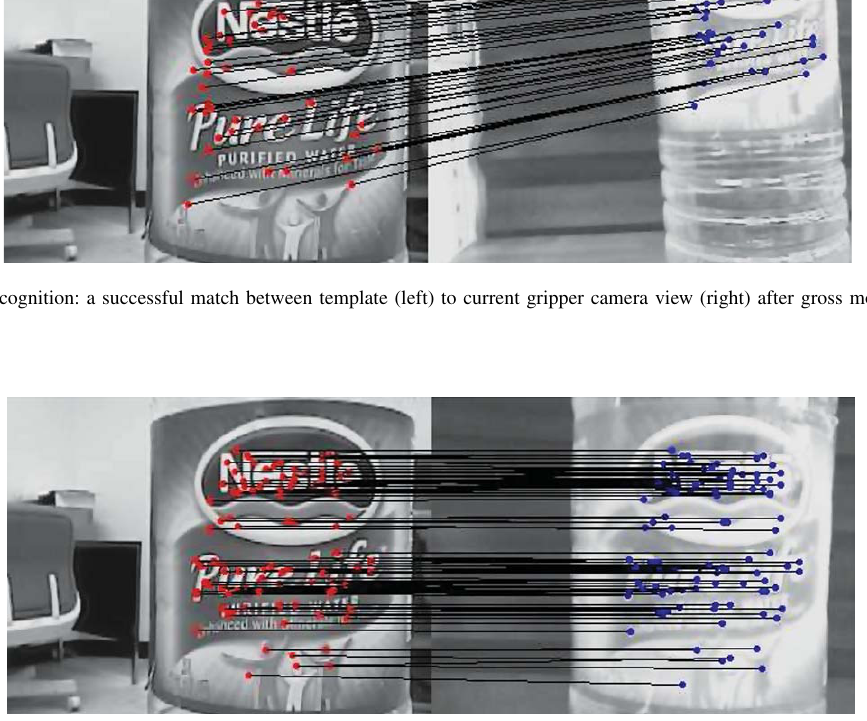
Fig. 8. Successful fine motion alignment between template (left) and left gripper camera view (right) (best viewed in